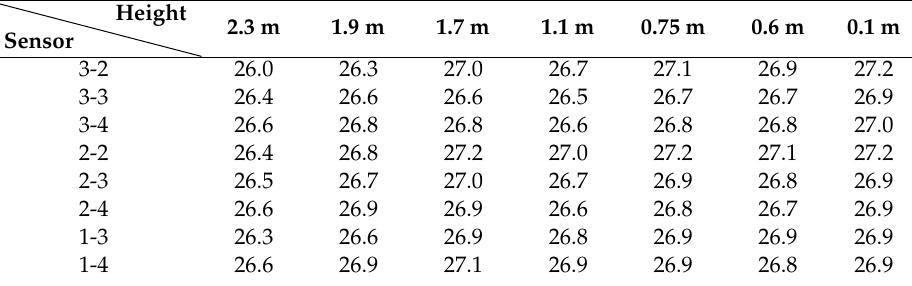
Table 8. Indoor temperature at di ff erent levels under condition D.